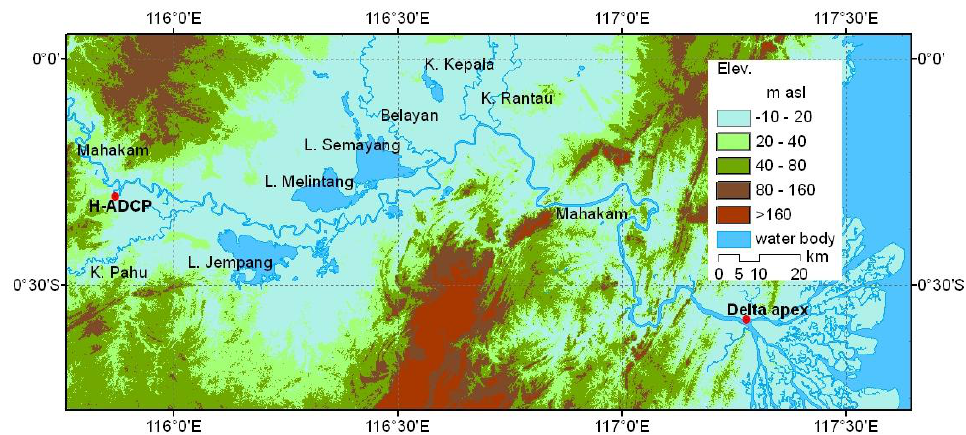
Fig. 1. Location of H-ADCP discharge station in the Mahakam River, plotted on a digital elevation model obtained from Shuttle Radar Topographic Mission (SRTM) data.